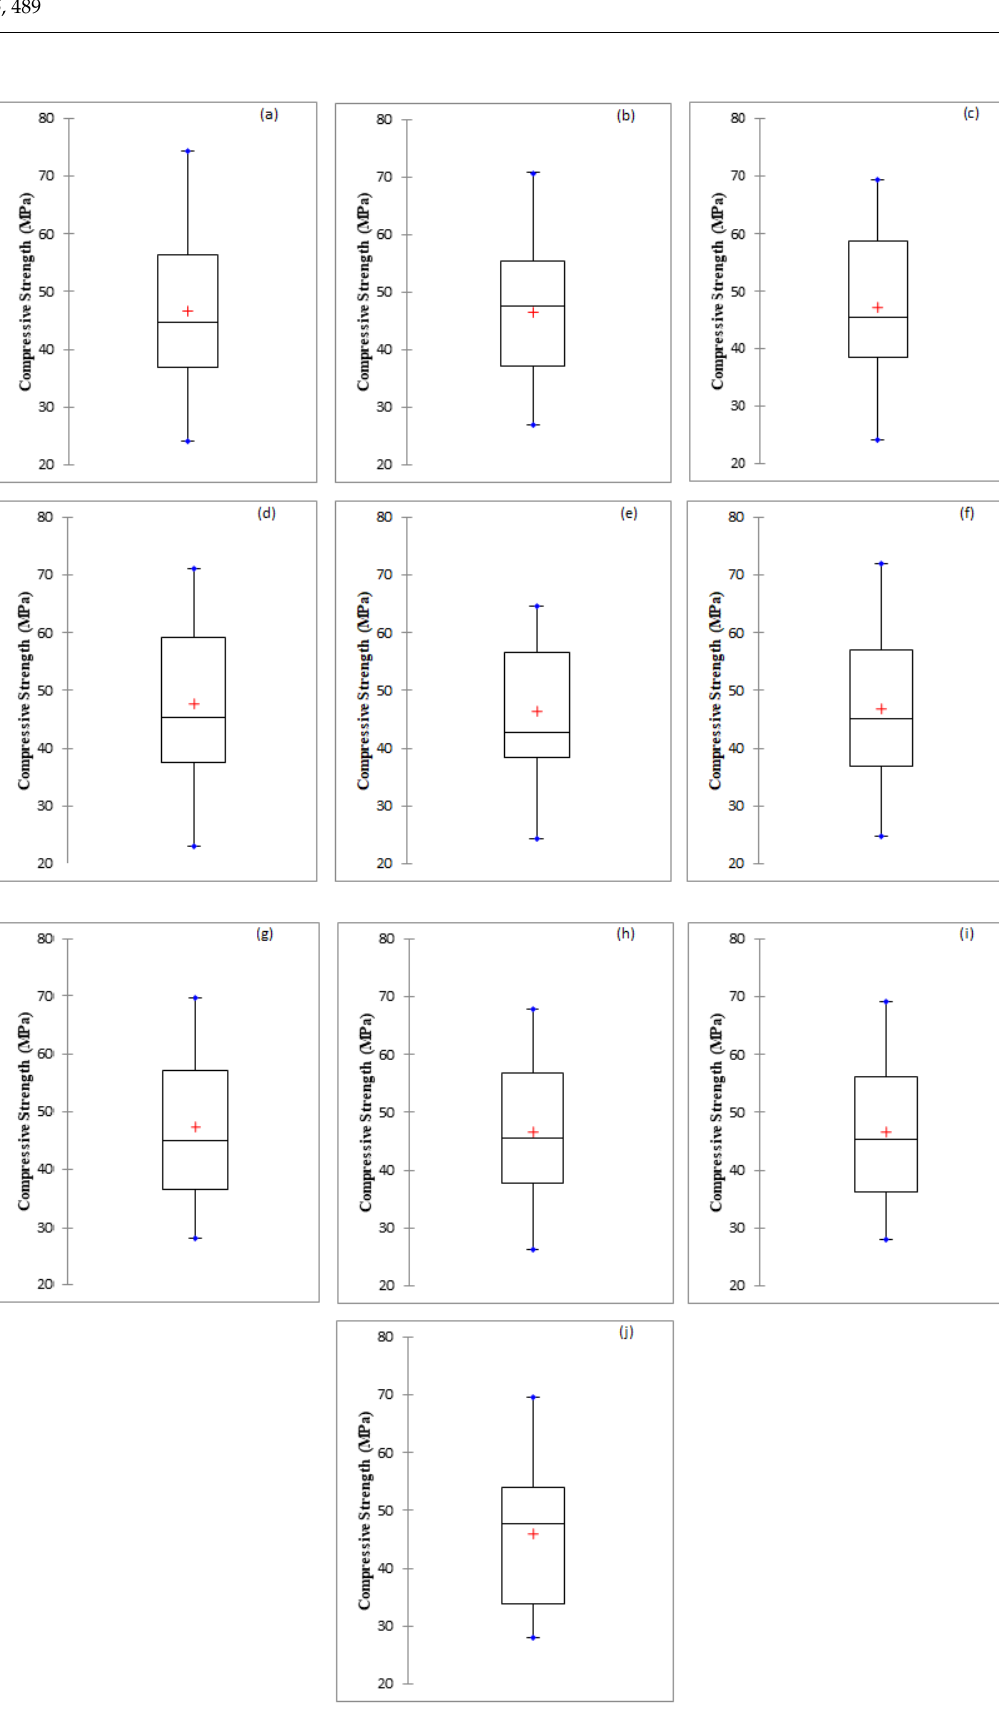
Figure 4. Box plot diagram ( a ) Actual, ( b ) M5P, ( c ) RF, ( d ) RT, ( e ) REP Tree, ( f ) SVR_Poly, ( g )